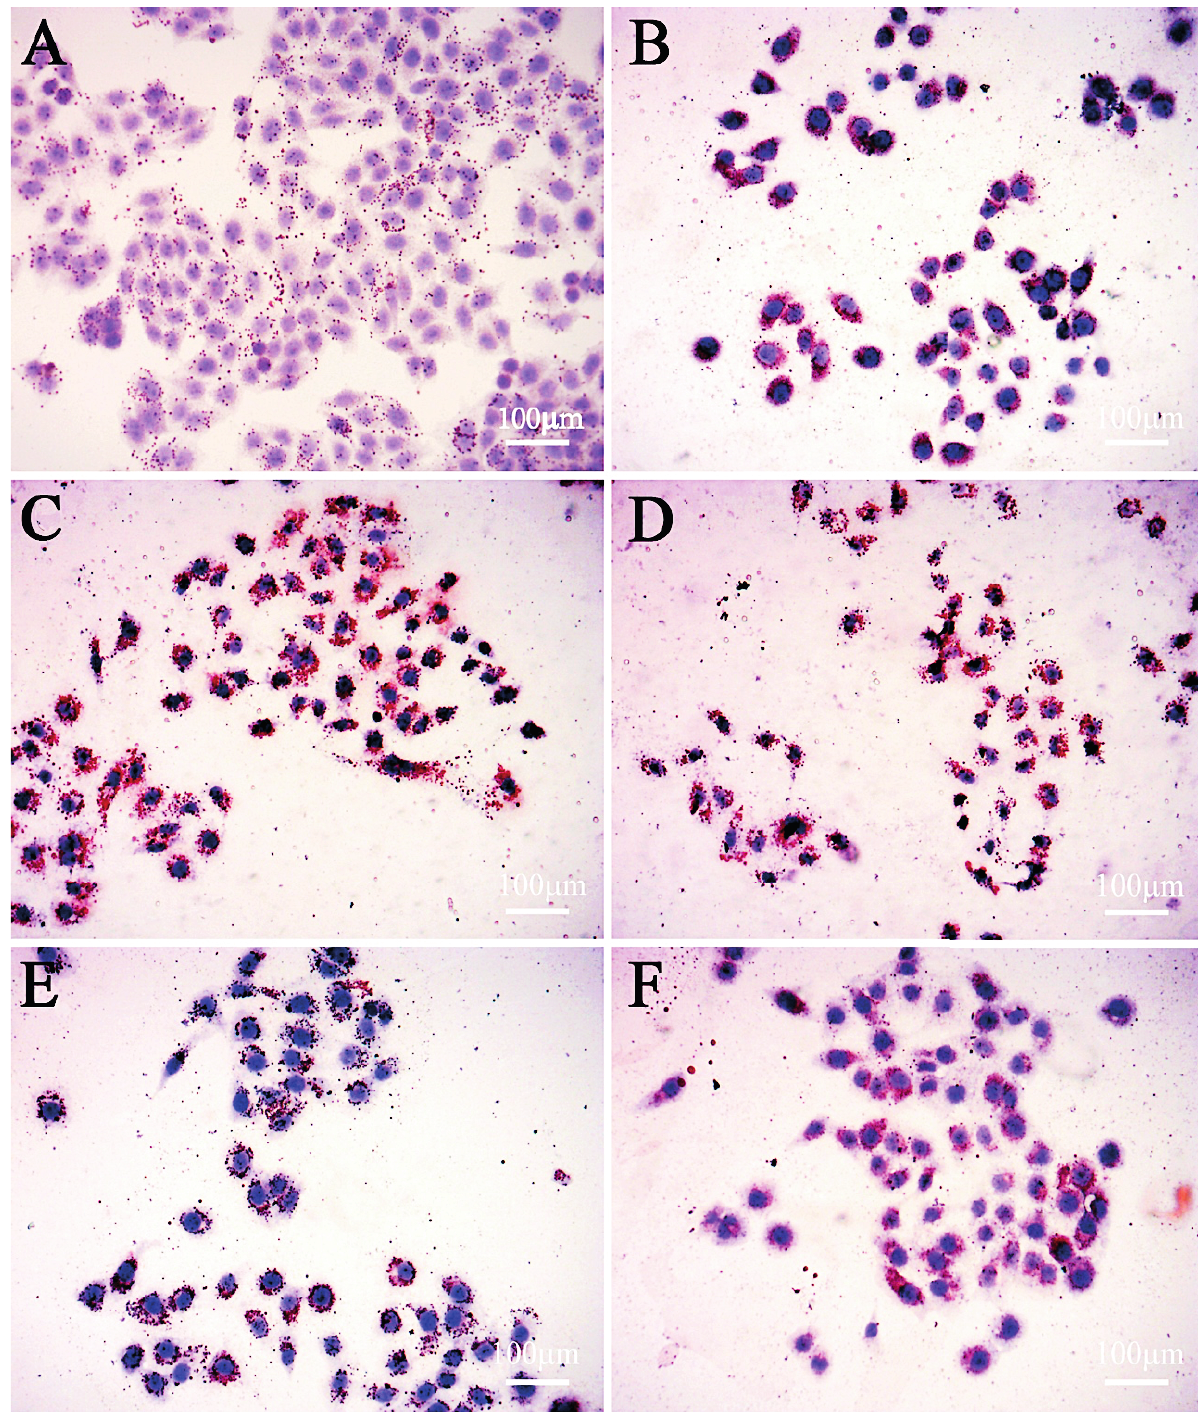
Figure 2: Oil Red O staining of L-O2 cells in each group. A: Normal group; B: Fenofibrate group; C: Model group; D: Low dose group; E: Medium dose group; F: High dose group. The hepatocytes in the model group were affected with orange lipid droplets of different sizes and diffuse orange lipid droplet fusion (scale bar 100